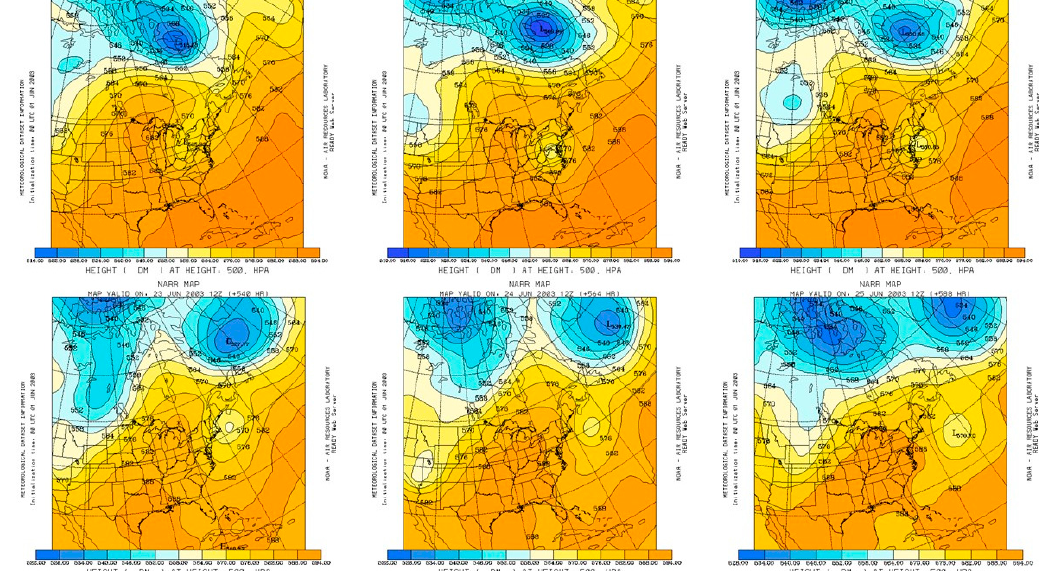
Figure 2. Daily 500 hPa GPH from June 20 ( upper left ) to 25 ( lower right ), 2003. Credit: NOAA ARL (website: http://www.arl.noaa.gov/index.php).